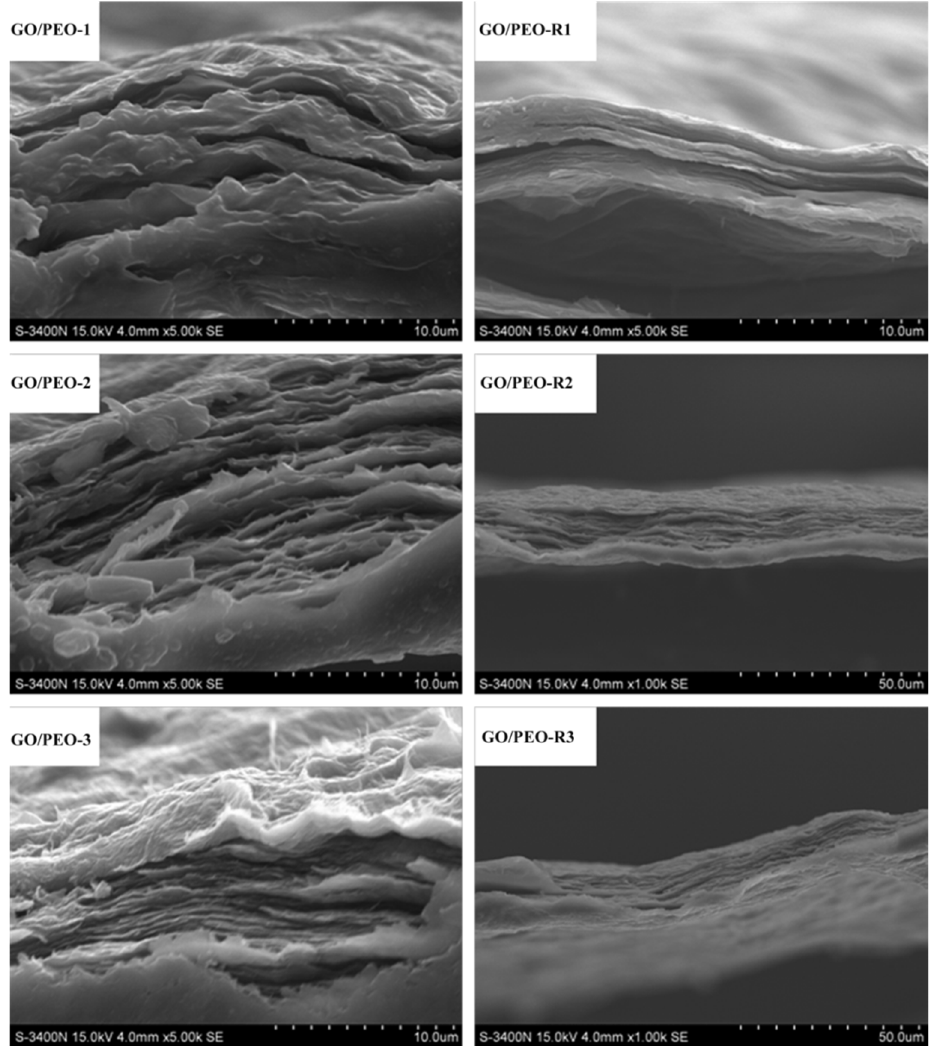
Figure 4. SEM images of the films from section view.